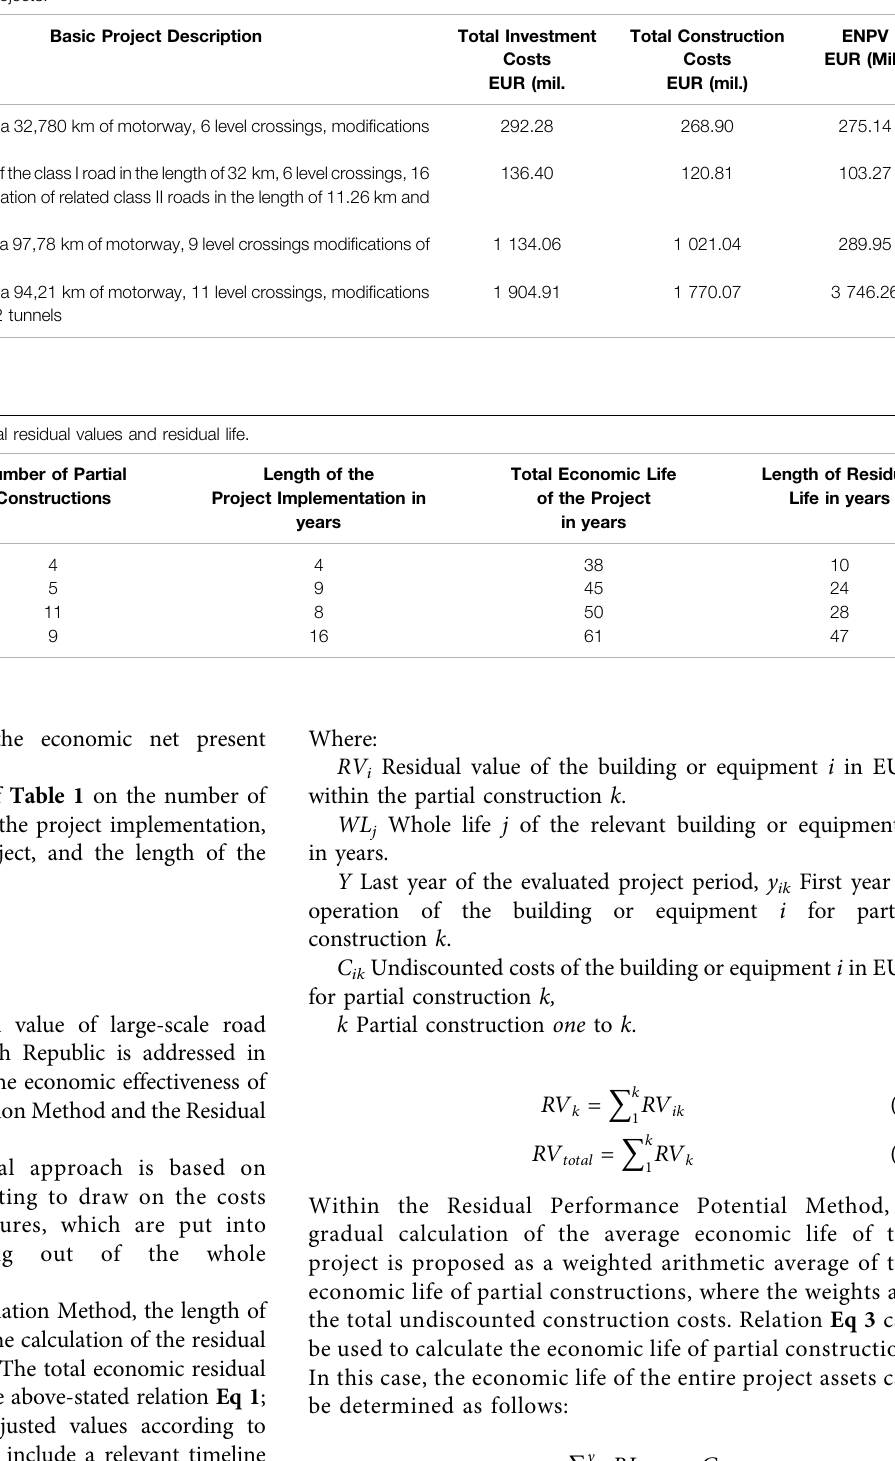
TABLE 1 | Basic description of investment projects.